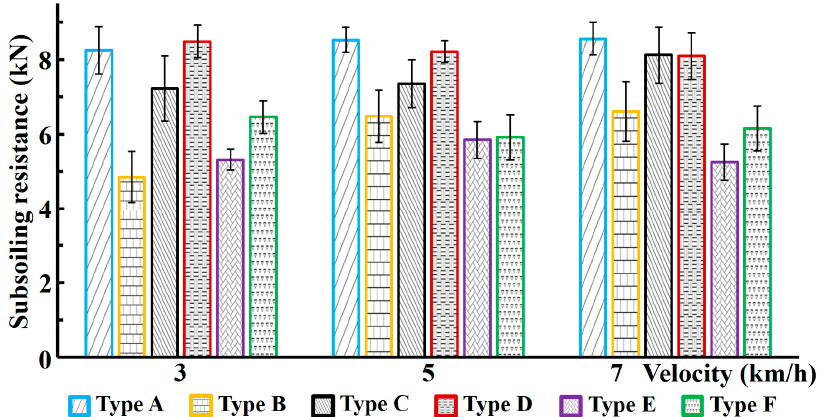
Figure 12. The minimum resistance variation law of vibration subsoiling at three speeds for six subsoiler